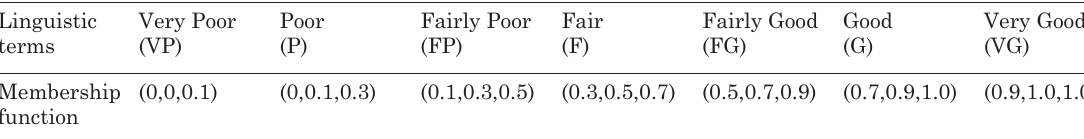
table 2. linguistic terms used by the decision ratings linguistic terms